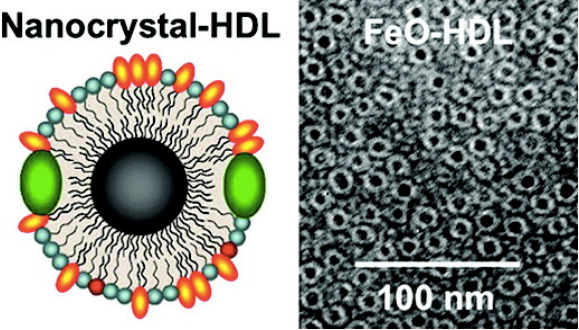
Figure 5. Schematic structure and TEM imaging of HDL-iron oxide nanoparticles. Adapted with permission from [149]. Copyright 2008, American Chemical